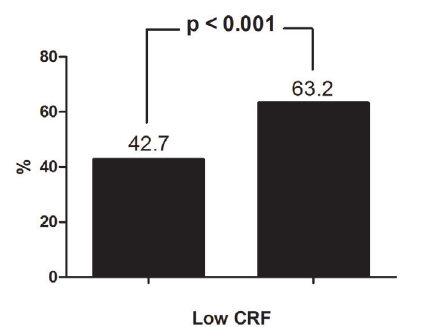
Figure 2. Incidence of low cardiorespiratory fitness at 4-year fol- low-up.